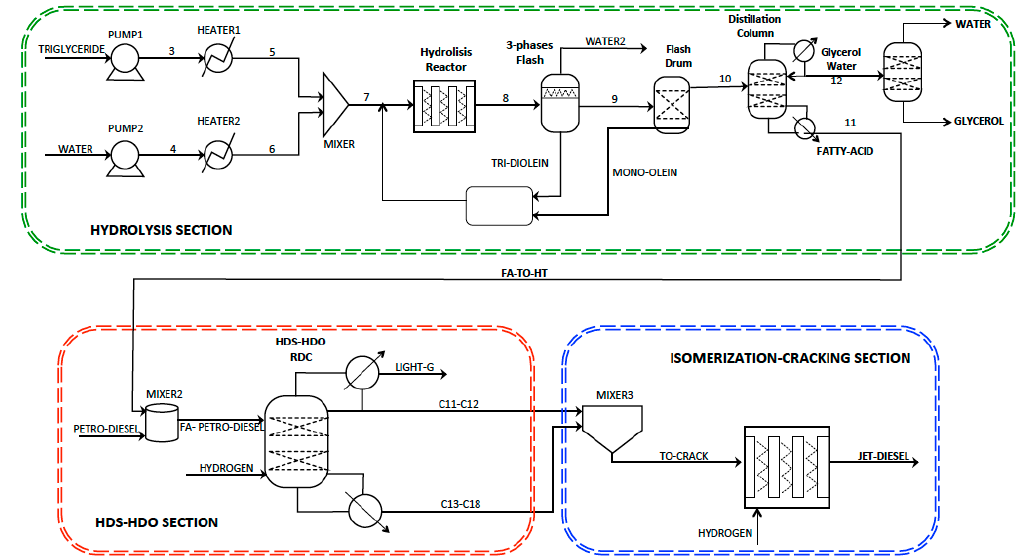
Figure 2. Simplified three-step reaction-separation process for bio-jet diesel production.